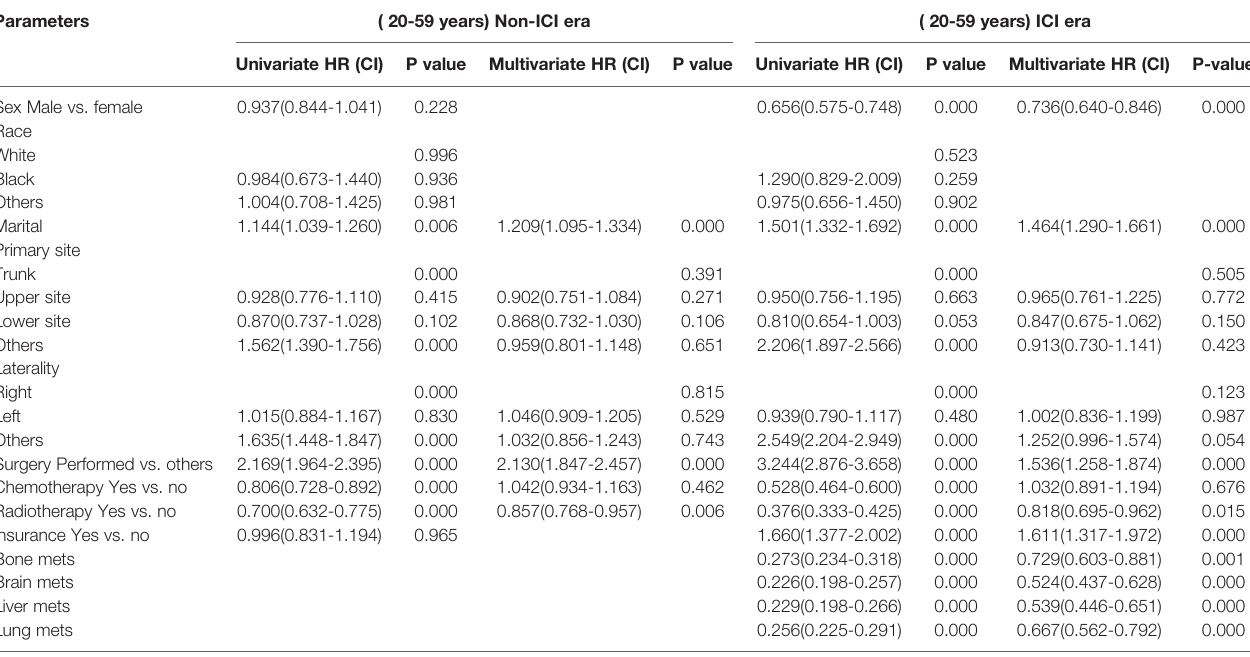
TABLE 3 A. | Univariate and multivariate analysis of factors affecting the survival in non-ICI era and ICI in fi rst age group. Parameters